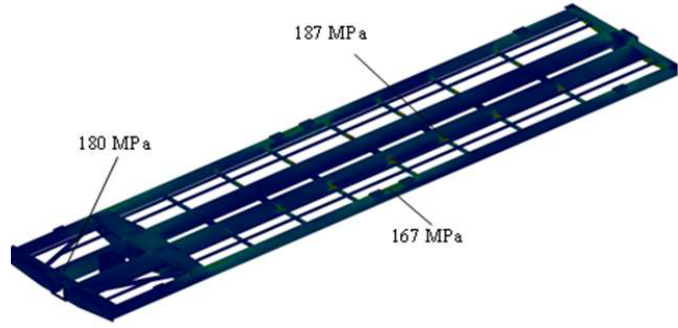
Figure 11. Stress state of the articulated flat wagon section.